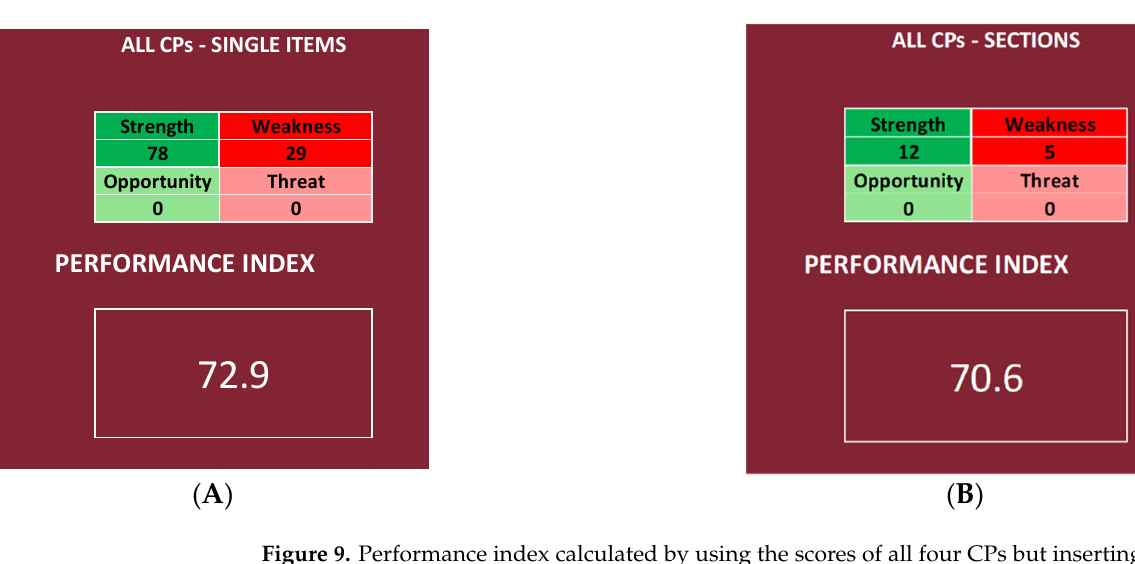
Figure 8. Extraction of the last Excel sheet of SPRIS ( NGSA ). It shows the NGSWOT Analysis compiled by using the priority scores of each item, regardless of the CP or the OU/ward, and the performance index calculated with them. It is possible to obtain two different performance indexes, one by inserting in the NGSA the priority scores of the items and the other by using the Questionnaire Sections, regardless of the CP or the OU/ward (Figure 9). The same was performed for each CP, obtaining for each CP two different performance indexes, one by inserting in the NGSA the priority scores of the items (deeper analysis) and the other by using the Questionnaire Sections (shallower analysis).